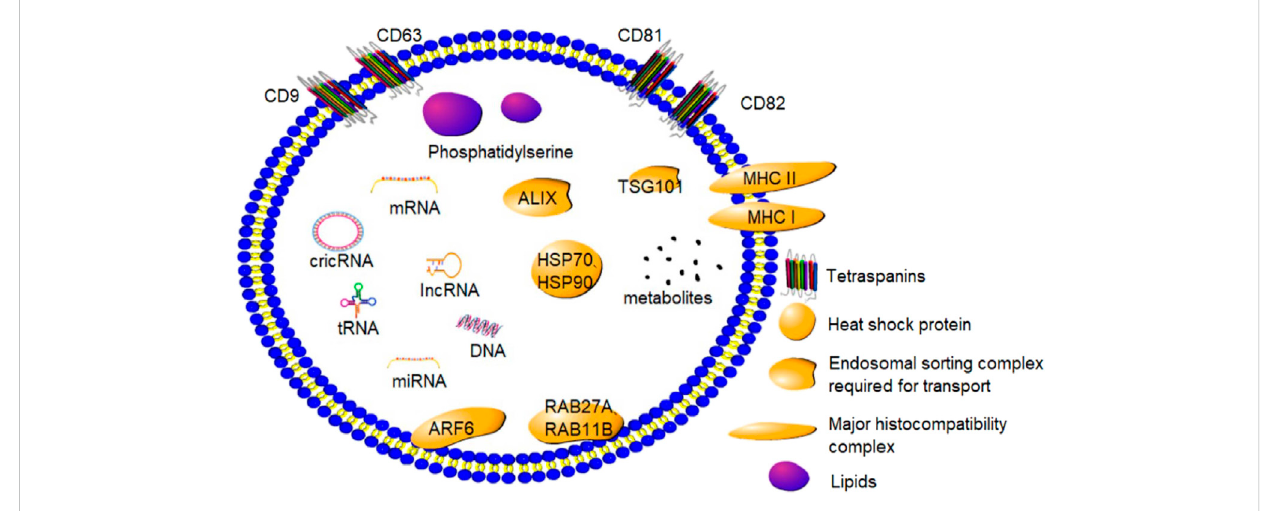
FIGURE 1 Composition and marker proteins of exosomes: Exosomes are small phospholipid bilayer vesicles that contain a variety of proteins, lipids, and nucleic acids. CD9, CD63, CD81, and CD82 are marker proteins of